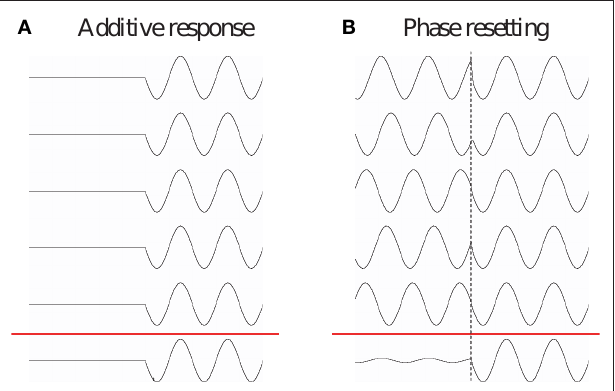
Figure 2 | The additive and phase-resetting theory of evoked response generation. (A) The additive theory implies that evoked and ongoing activities are separate and distinct neuronal phenomena. The stimulus “evokes” an additive, phase-locked response in each trial. (B) According to the phase- resetting view, upon the onset of a stimulus, the phases of the ongoing background oscillations become aligned (phase-reset or partial phase-reset) to the stimulus. By averaging the stimulus-locked trials, the phase-locked oscillatory activity emerges as an evoked